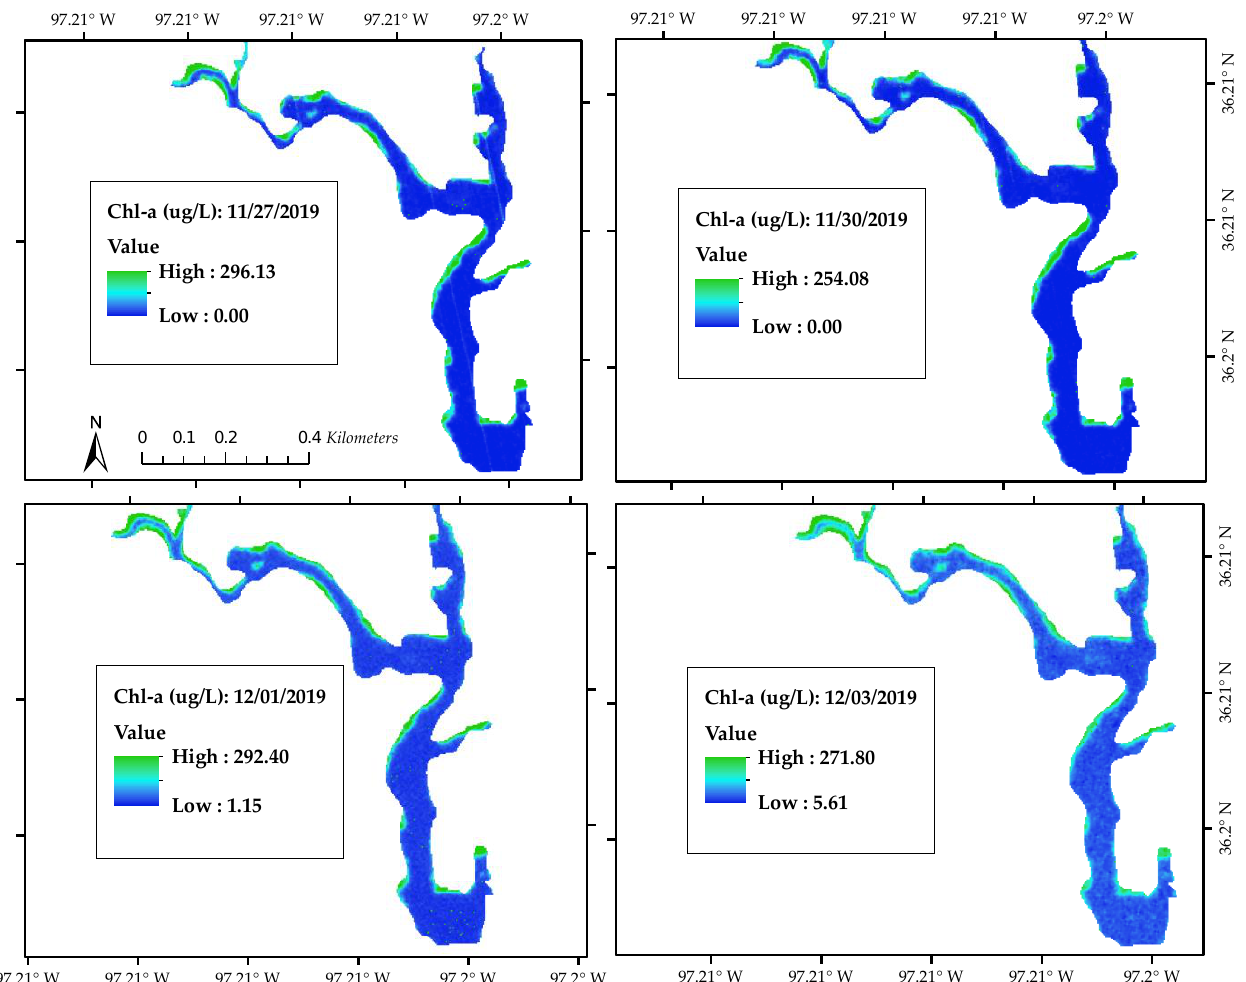
Figure 9. PlanetScope maps of Chl-a on four dates of image acquisition in Lake McMurtry, northcentral Oklahoma. The upper left panel is from an image acquired on 27 November 2019; the upper right panel is from an image acquired on 30 November 2019; the lower left panel is from an image acquired on 1 December 2019; the bottom right panel is from an image acquired on 3 December 2019. The color bars in the legends represent Chl-a concentration ranges on each date.